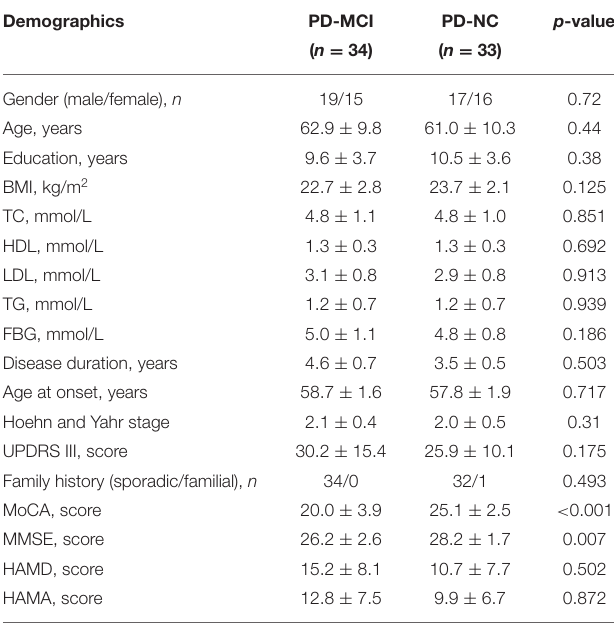
TABLE 1 | Sample demographic and clinical